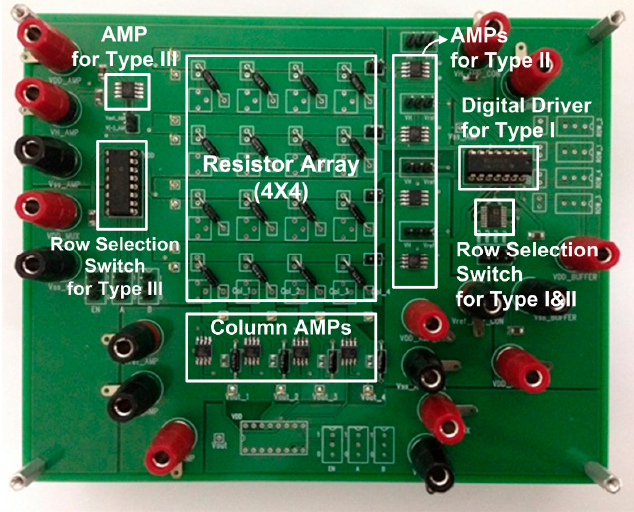
Figure 13. Test board with row drivers Type I, II, III, and 4 × 4 resistor array.